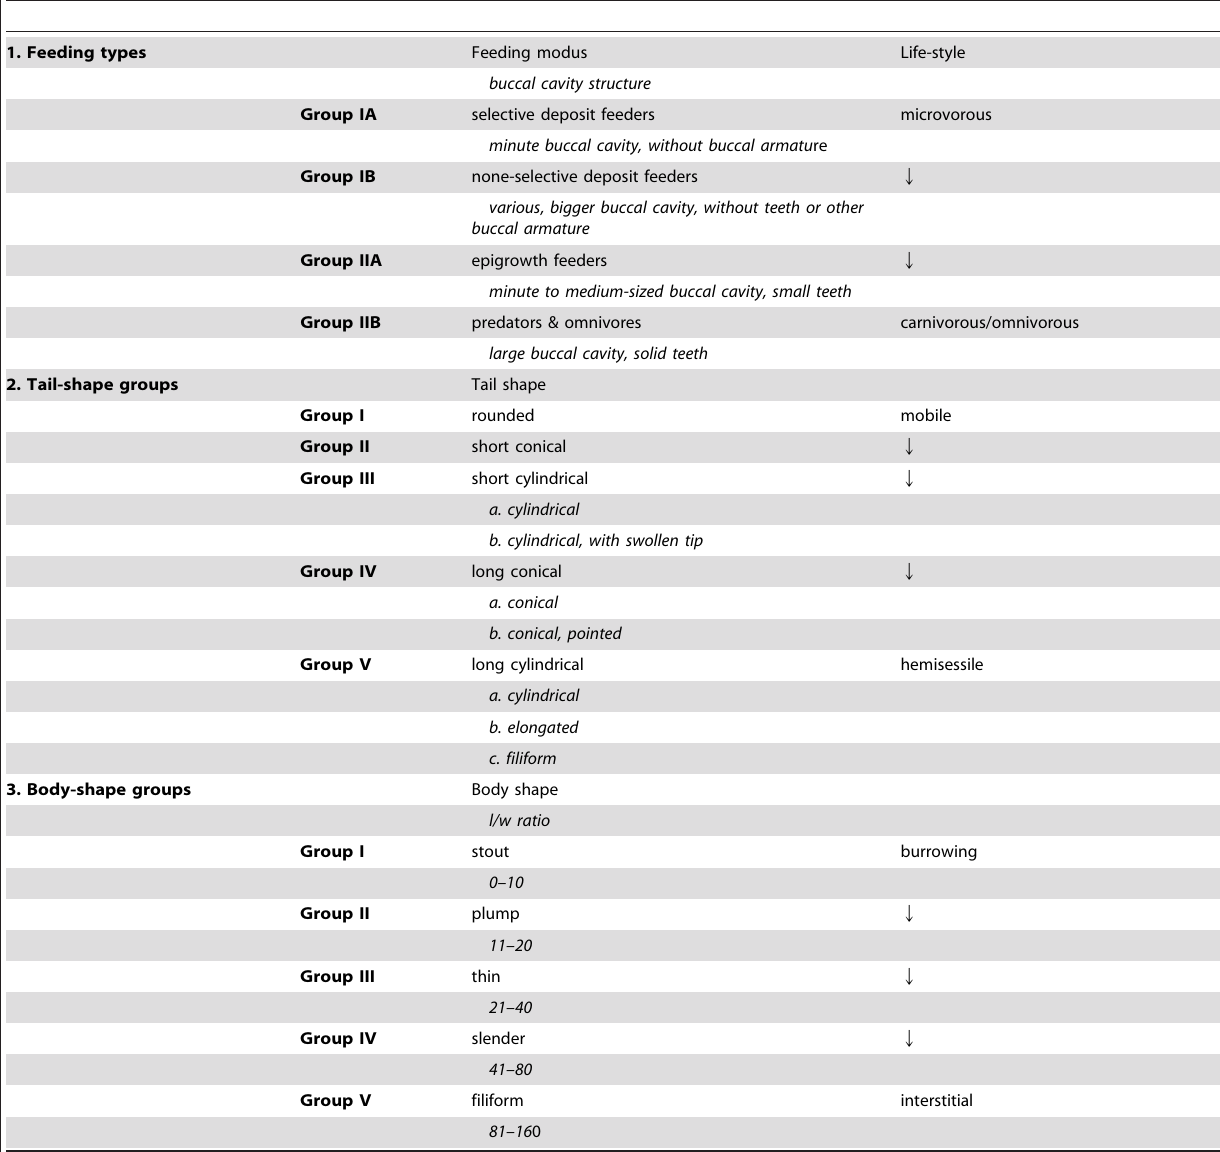
Table 1. Functional classification of the nematodes based on morphological traits concerning buccal cavity structure, tail and body